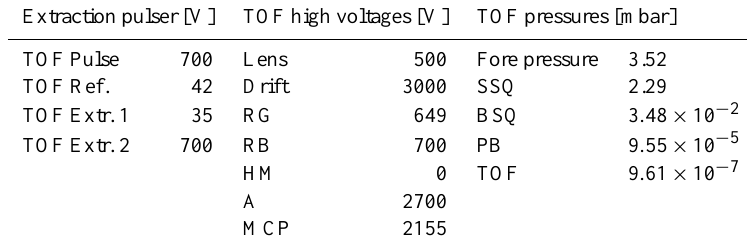
Table A3. Voltages and pressures in the TOF section (operated in negative high sensitivity